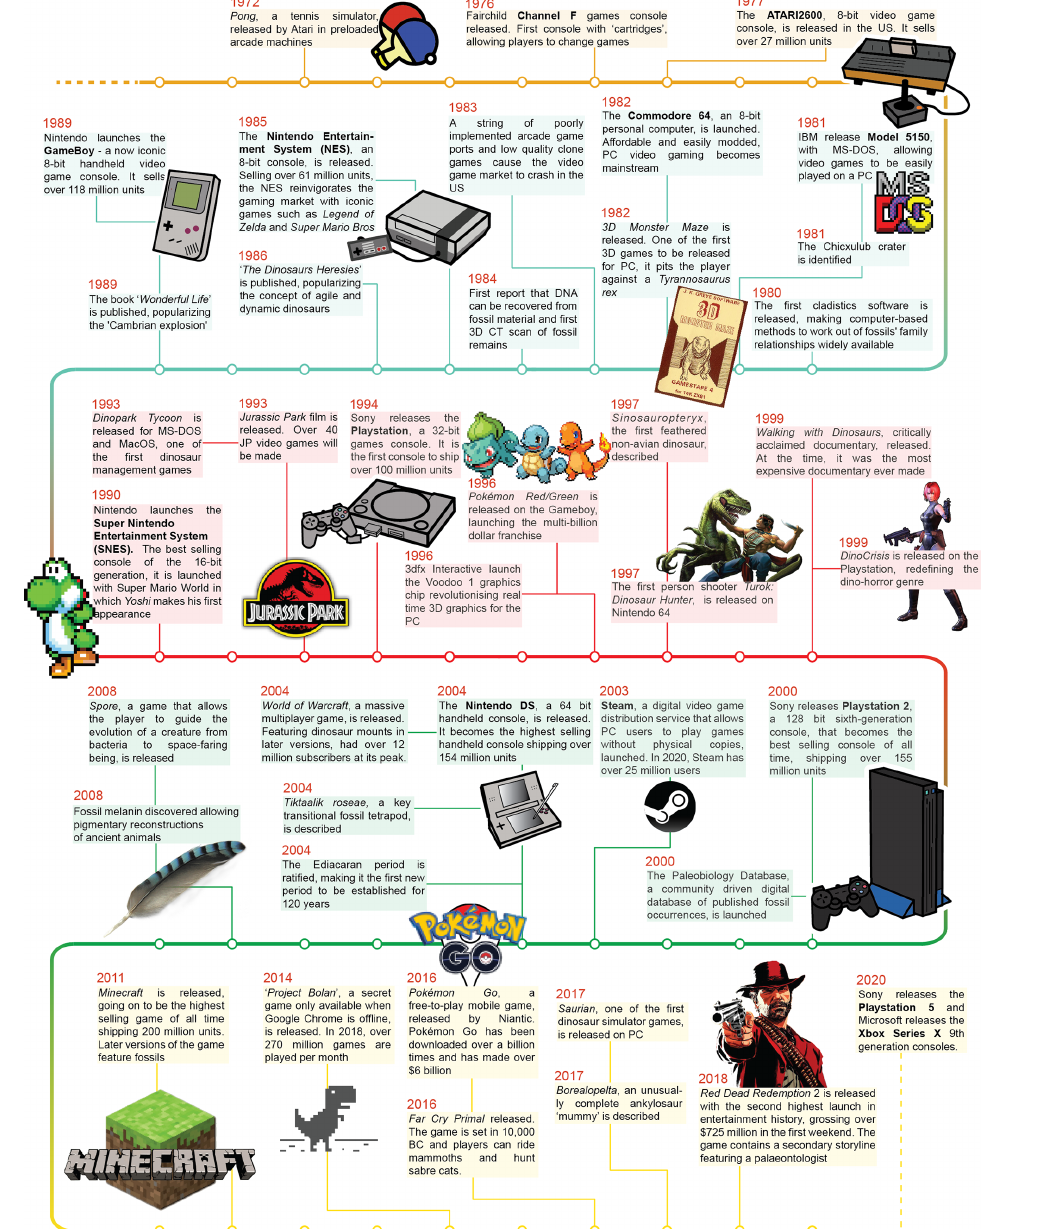
Figure 1. A timeline of major events in palaeontology, video games, and palaeontological video games between 1970–2020.